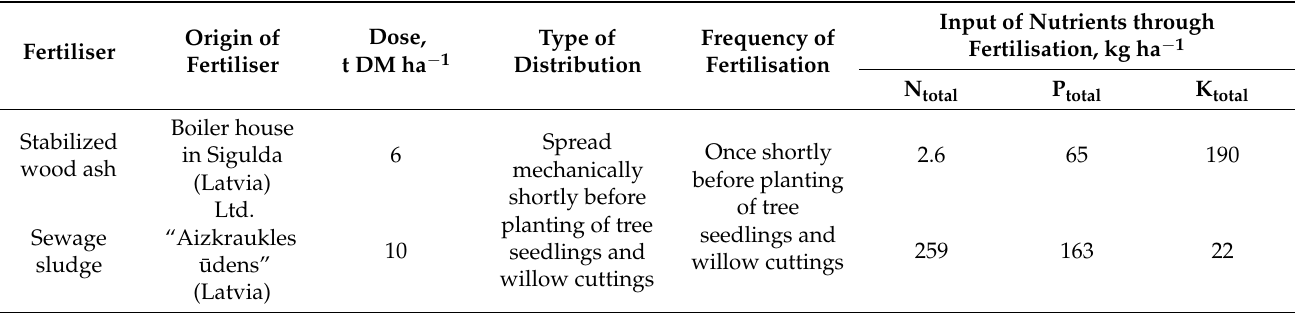
Table 1. Characterisation of initially applied soil fertilisation management practices at the study site in the spring of 2011.